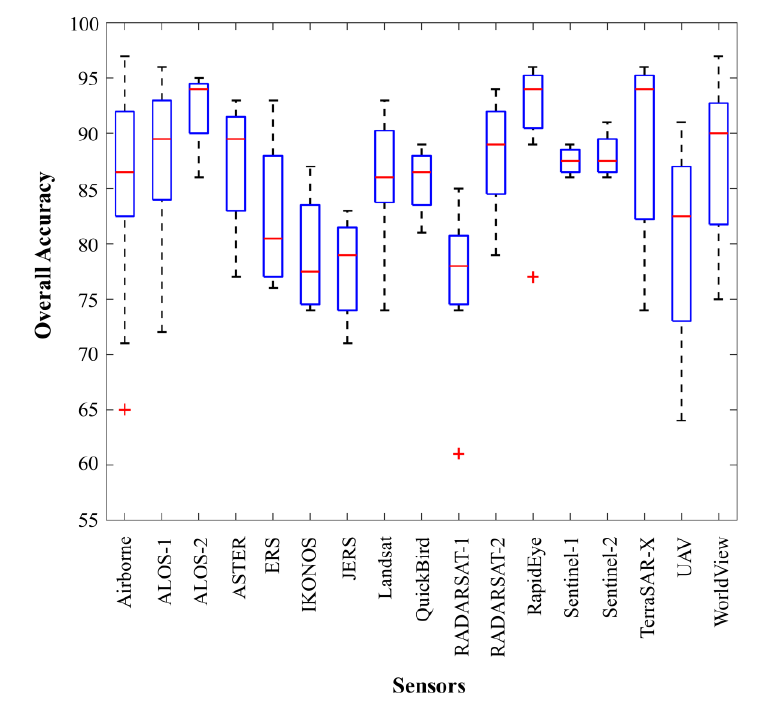
Figure 15. Overall accuracy of various sensors. 463